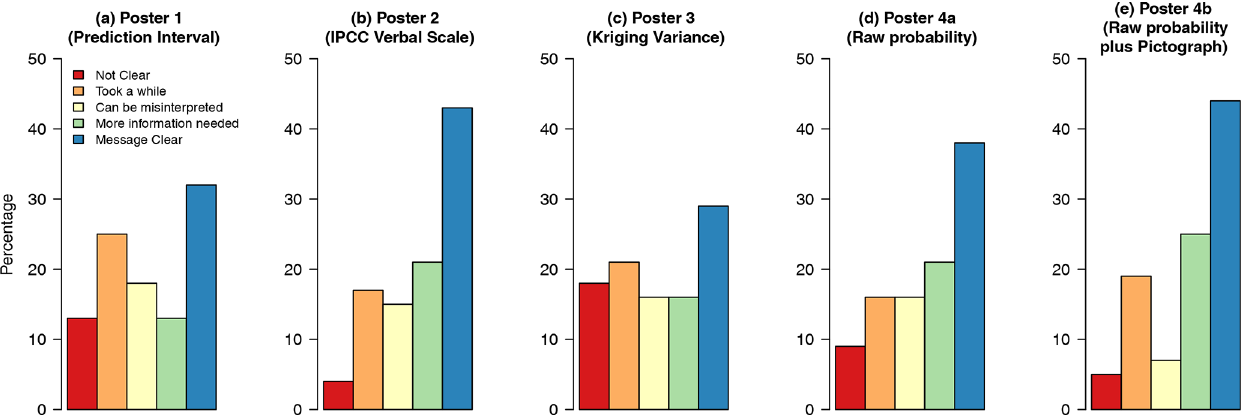
Figure 4. Bar charts showing how participants responded to whether a method is straightforward to interpret (Q5).